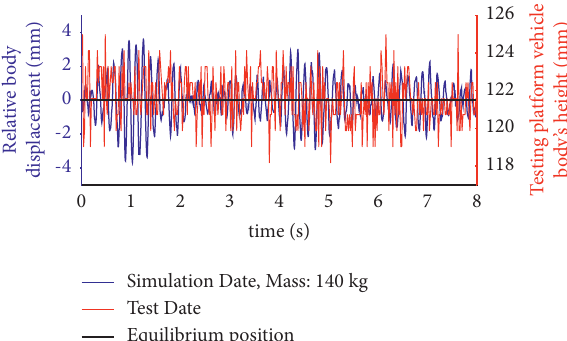
Figure 15: Test and simulation time-domain results of the vehicle’s body height and relative displacement under 140kg load.